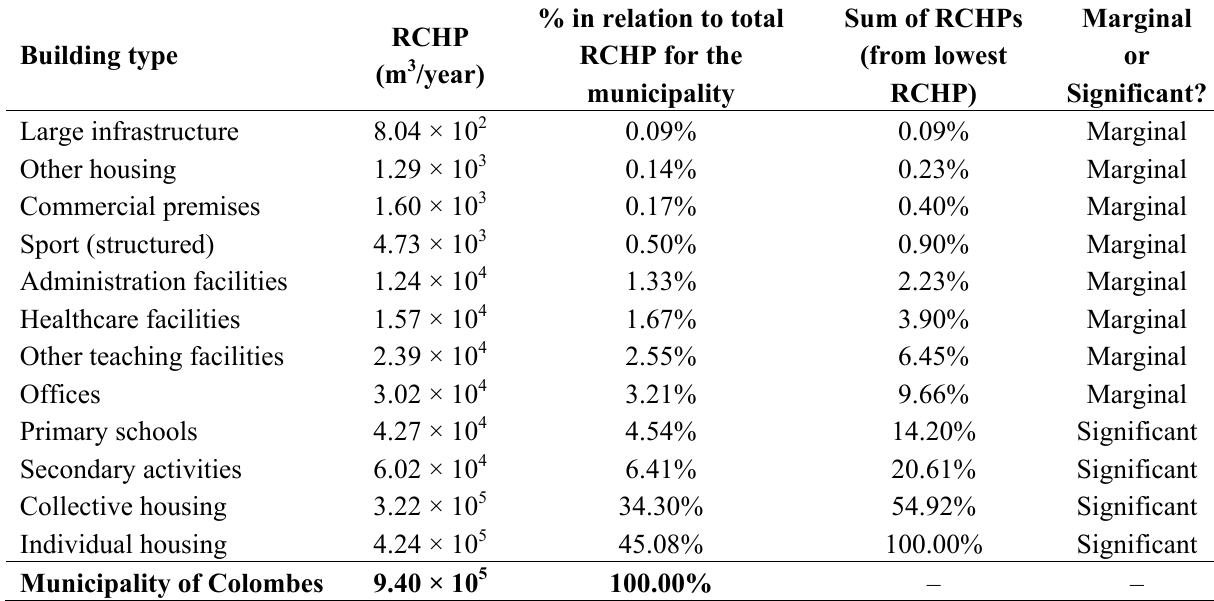
Table 3. Table of significant and marginal building types